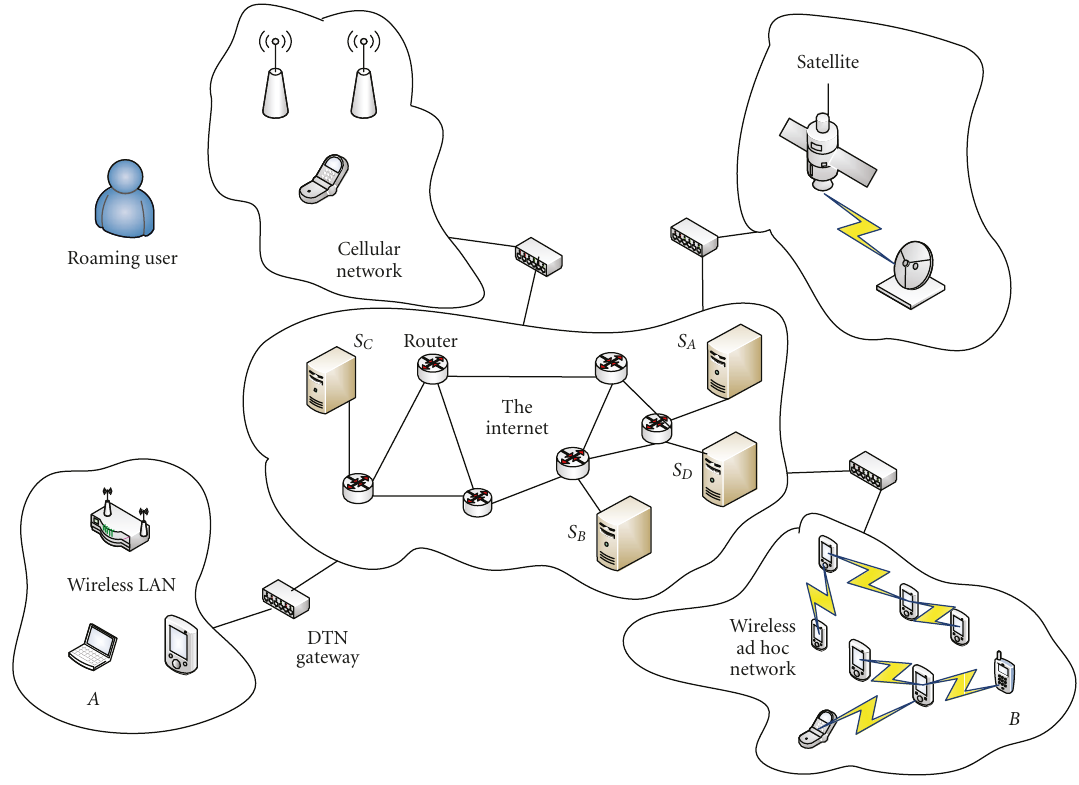
Figure 1: An illustration of the supernode system.